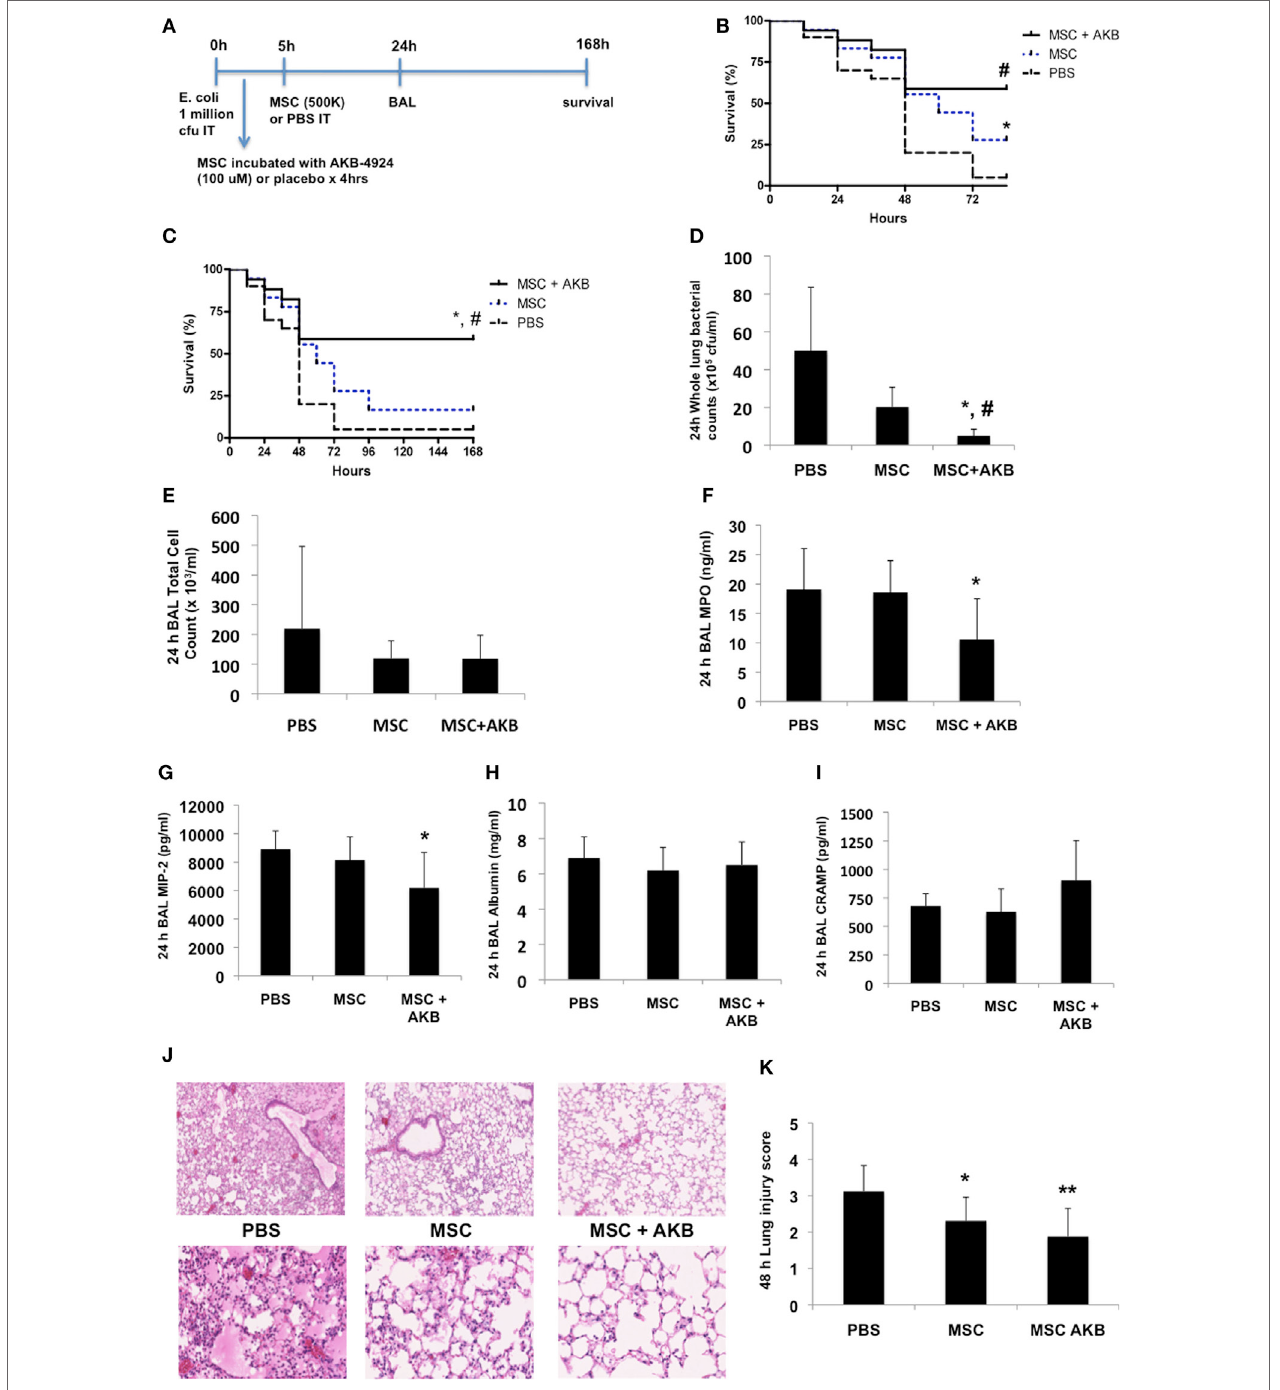
figUre 2 | AKB-4924 augments the therapeutic capacity of mesenchymal stem cells (MSCs) in an Escherichia coli pneumonia model. Following the experimental design outlined in panel (a) , both unstimulated MSCs and MSCs pre-incubated with AKB-4924 (100 µM × 4 h) significantly improved the survival of mice at 72 h [ (B) , # p < 0.05 for MSC + AKB vs PBS, * p < 0.05 for MSC vs PBS, n = 17–20 per group], while only AKB-4924 stimulated MSCs increased survival over 7 days [ (c) , * ,# p < 0.05 for MSC + AKB vs MSC and PBS treated groups, respectively, n = 17–20 per group]. AKB-4924 also significantly improved the ability of MSCs to reduce whole lung bacterial burden [ (D) , * ,# p < 0.05 for MSC + AKB vs MSC and PBS treated groups, respectively, n = 5–6 per group], alveolar neutrophil influx as measured by bronchoalveolar